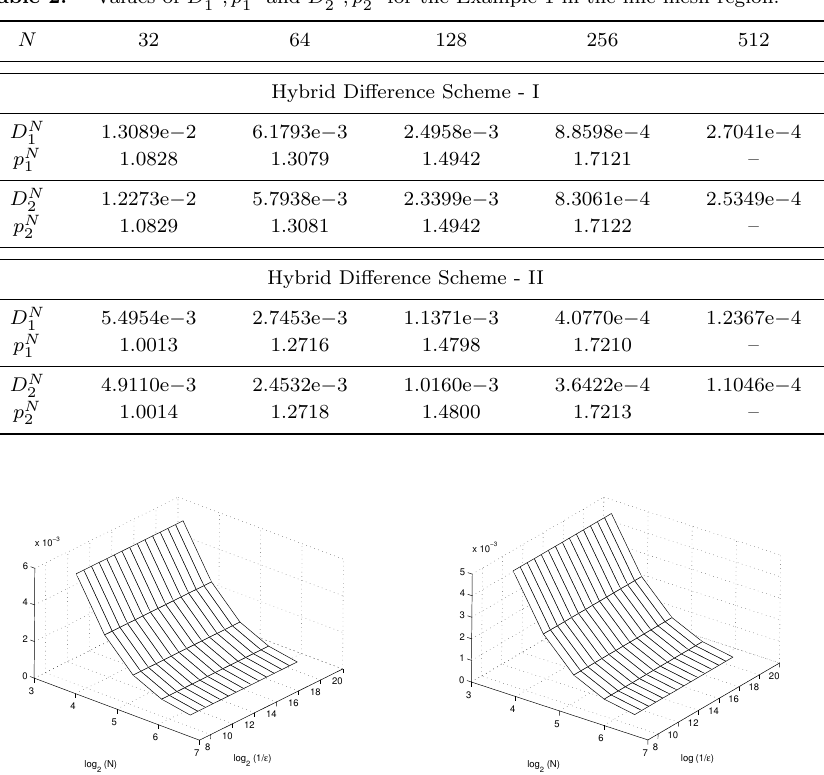
Table 2. Values of D N